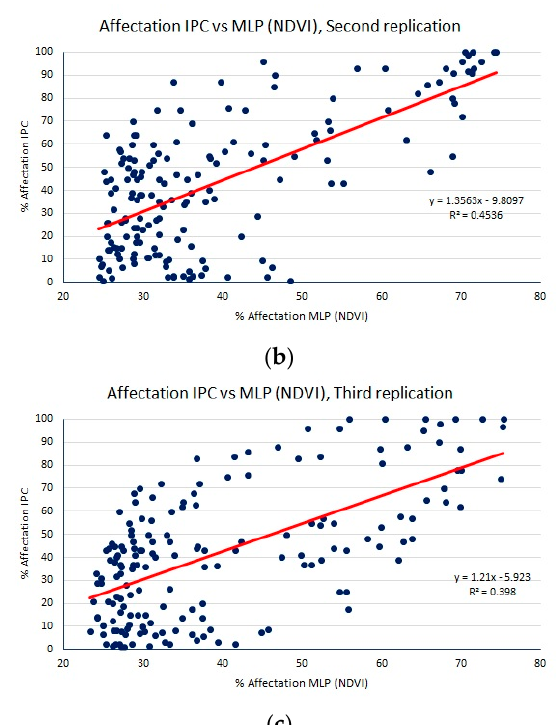
Figure 6. Percentage of P. infestans affectation using IPC methodology vs. estimated percentage of affectation using MLP on the NDVI dataset, for ( a ) first replication, MAE: 18.48, RMSE: 21.58, R 2 : 0.4823; ( b ) second replication, MAE: 18.84, RMSE: 22.24, R 2 : 0.4536; ( c ) third replication, MAE: 18.79, RMSE: 22.12, R 2 : 0.398. NDVI: Normalized Difference Vegetation index.